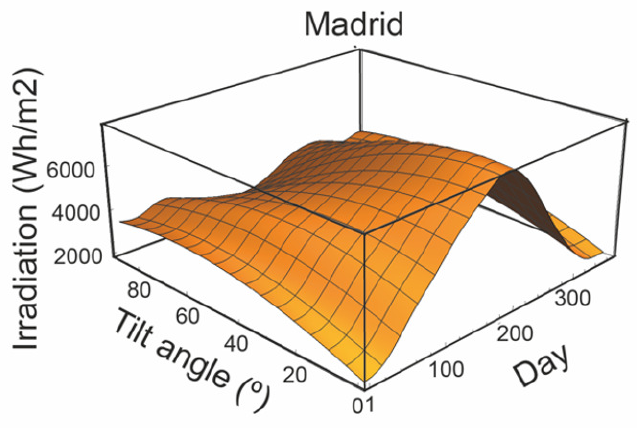
Figure 3. Adjusted total solar irradiation on a tilted surface H t ( n , β ,0 ) for